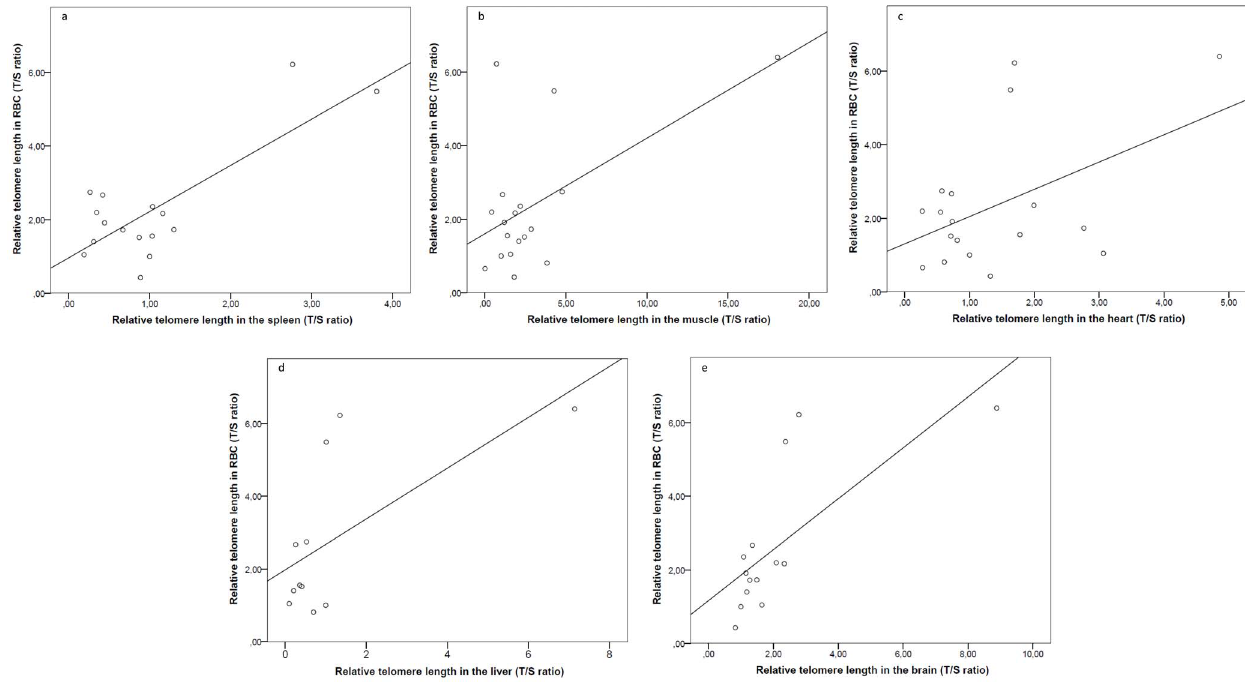
Figure 2. Correlations between red blood cells telomere length and telomere lengths in different somatic tissues. a. Correlation between red blood cells telomere length and spleen telomere length. b. Correlation between red blood cells telomere length and muscle telomere length. c. Correlation between red blood cells telomere length and heart telomere length. d. Correlation between red blood cells telomere length and liver telomere length. e. Correlation between red blood cells telomere length and brain telomere